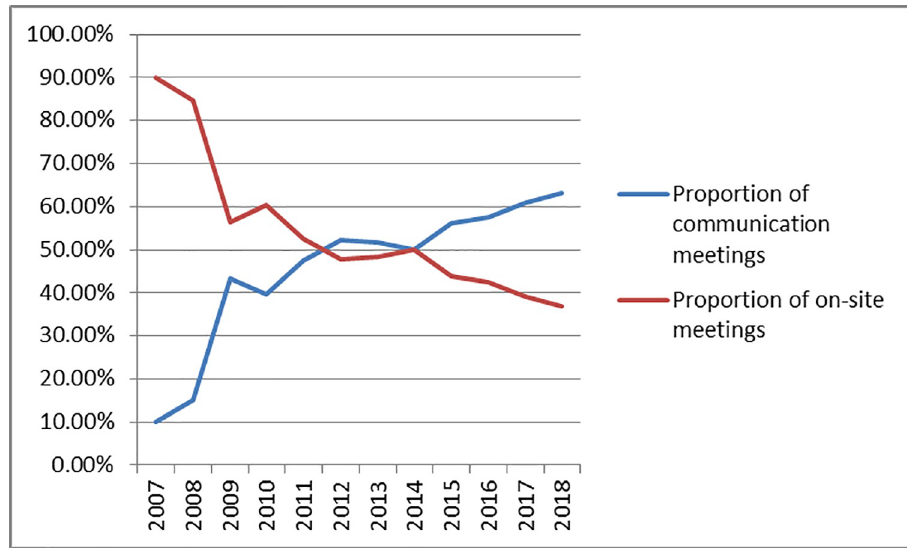
Fig 2. Proportion of the board